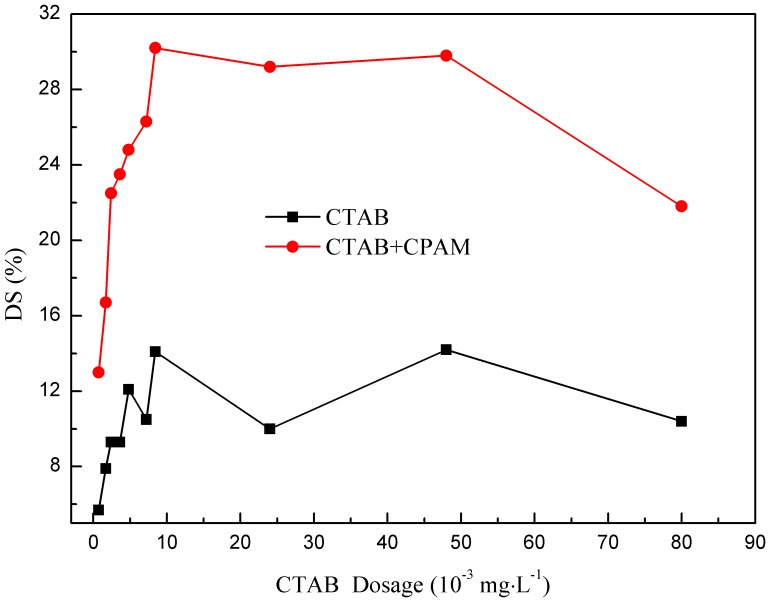
Effect of surfactant dosage on DS.